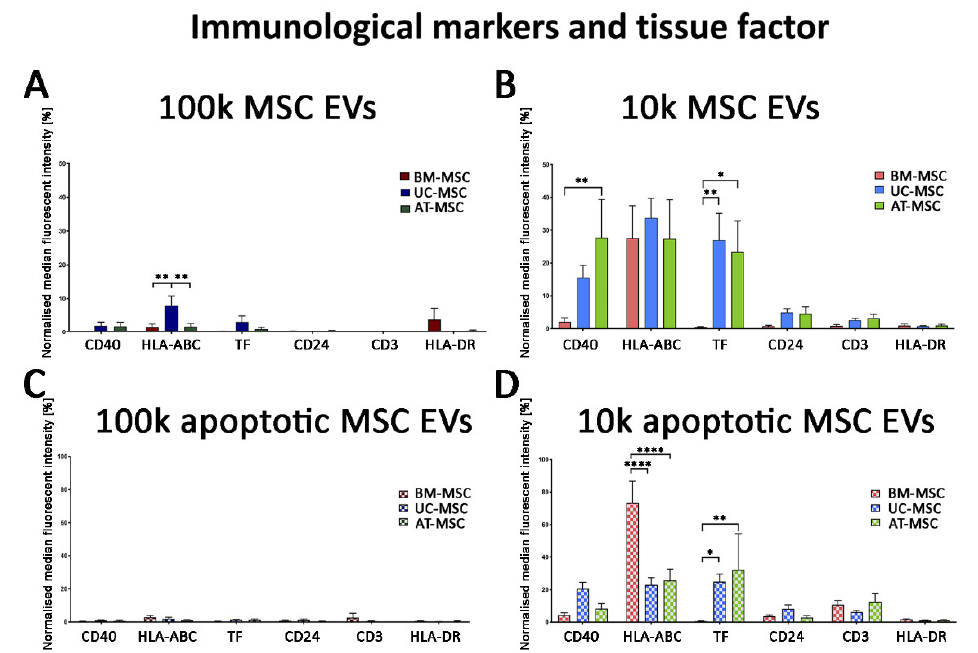
Figure 10. MACSPlex immunological marker analysis of 100k and 10k MSC EVs of naive and apoptotic MSCs. ( A – D ) Histograms represent normalised fluorescence intensity of immunity markers (CD40, HLA-ABC, CD24, CD3 and HLA-DR) and tissue factor (TF) for 100k MSC EVs ( A , C ) and 10k MSC EVs ( B , D ) isolated from naive ( A , B ) and apoptotic ( C , D ) MSCs. BM-MSC EVs, UC-MSC EVs and AT-MSC EVs were compared. Data are expressed as median fluorescence intensity normalised to the median fluorescence intensity of tetraspanins ± SD of three different experiments. A p value < 0.05 was considered significant (* p < 0.05, ** p < 0.001, **** p < 0.0001).